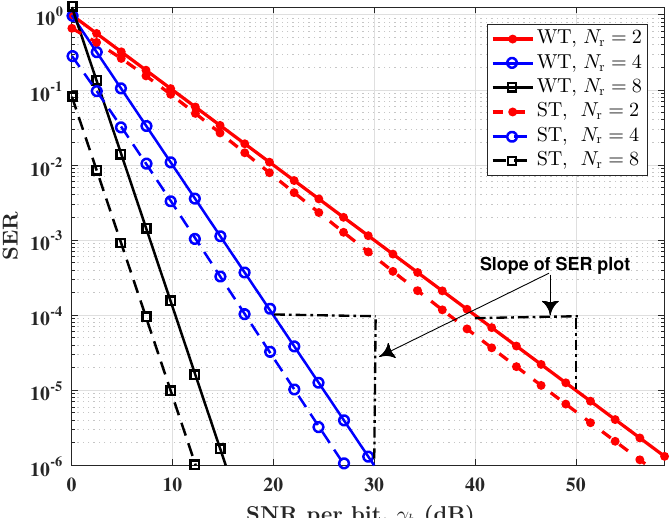
Figure 5. SNR required to achieve SER = 10 − 5 , using varying numbers of photodetectors (PDs). SPPM configuration: N t = 4, L =